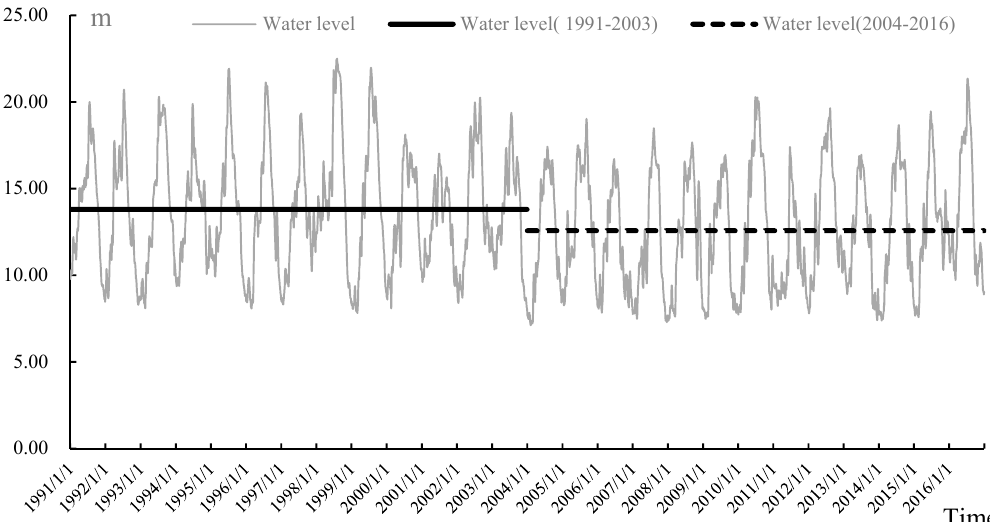
Figure 4. Daily water level at Xingzi Station of Poyang lake and Average water level during the period 1991–2003, 2004–2016.